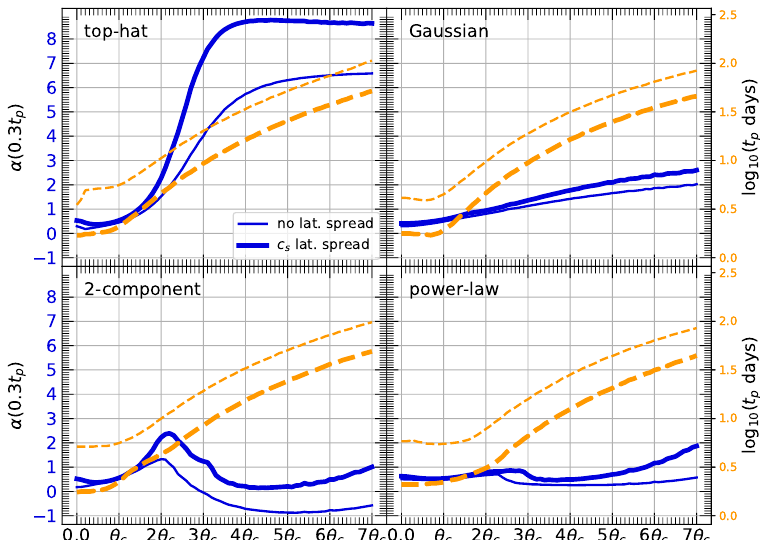
Figure 2. The temporal index at 0.3 × the observed lightcurve peak time at increasing inclinations (blue lines, left axis), and the observed lightcurve peak time for our model parameters for the cases with and without lateral spreading (orange, right axis). The x-axis shows the inclination as a factor of the core angle, θ c = 0.1rad. The lateral spreading model assumes a maximum sound speed sideways expansion and so should be considered an upper limit on the